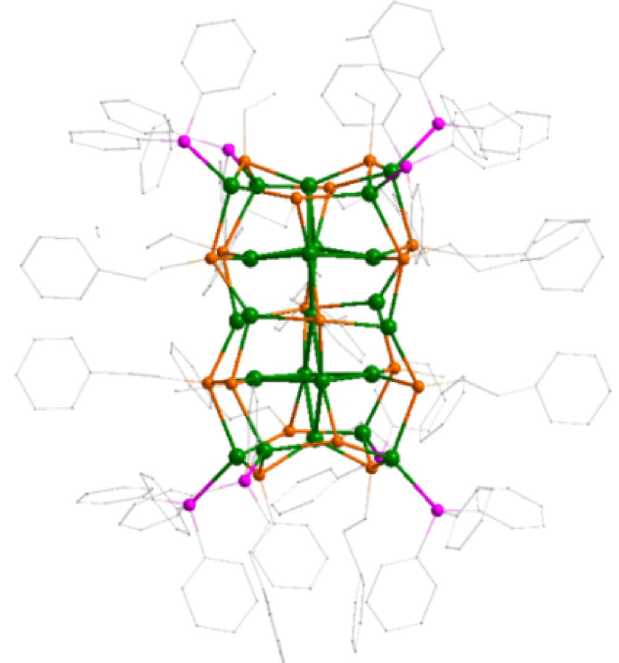
Fig. 1 Total framework of the Ag 23 (PPh 3 ) 8 (SC 2 H 4 Ph) 18 nanocluster. Color codes: Ag, green; S, orange; P, purple; C, gray. Hydrogen atoms are omitted for